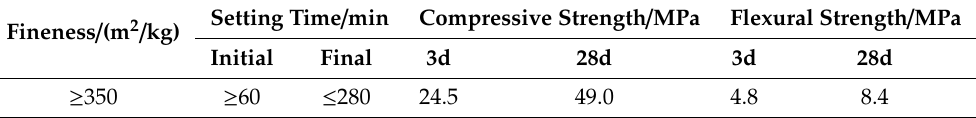
Table 2. Basic properties of cement.